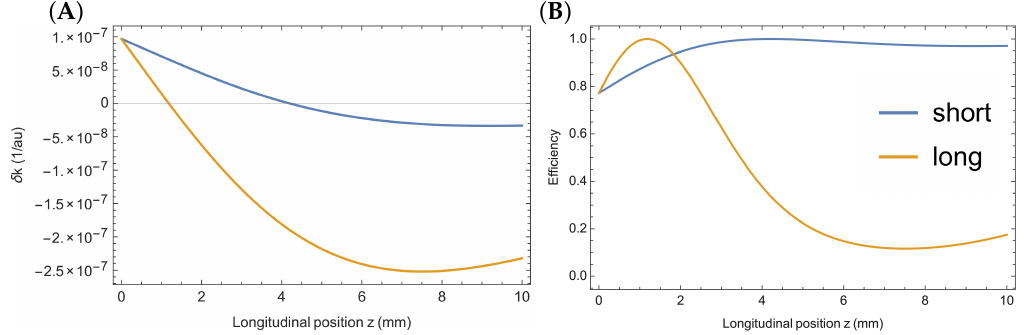
Figure 5. ( A ) phase mismatch for an example long and short trajectory, depending on the position of the gas jet after the laser beam focus; ( B ) phase matching efficiency for two example trajectories depending on the position of the gas jet z